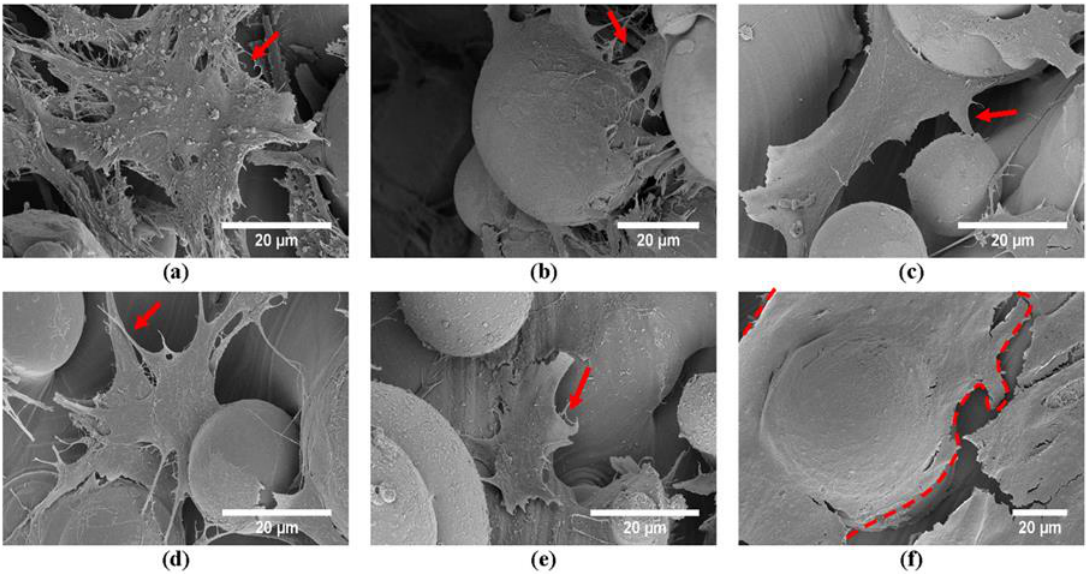
Figure 11. SEM images of the MC3T3 preosteoblast cells after culturing for 7 days on the top surfaces of ( a ) U0.4, ( b ) U0.6, ( c ) U0.8, ( d ) Dense-In, ( e ) Dense-Out, ( f ) solid scaffolds.